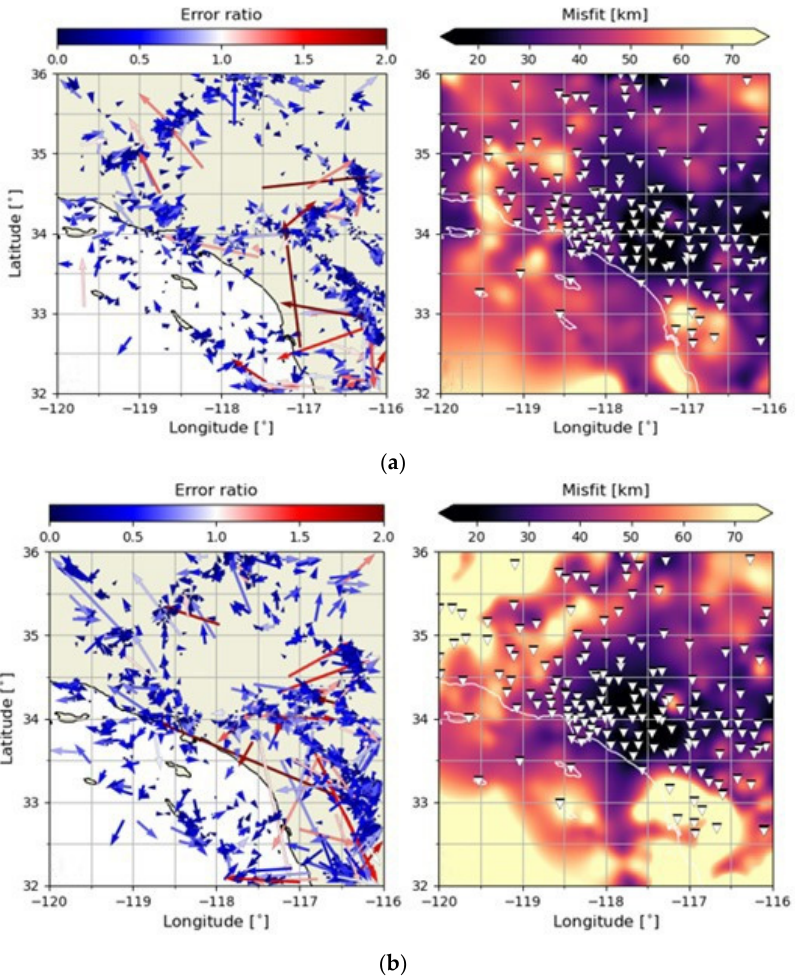
Figure 9. Residuals of the epicentral locations (in first column) and overlay of the locations of seismic stations (in second column) on the interpolated prediction error (in km) on the California dataset. ( a ) Residuals of the epicentral locations and overlay of the locations of seismic stations by GNN; ( b ) Epicentral residuals and an overlay of seismic station locations by BNGCNN.